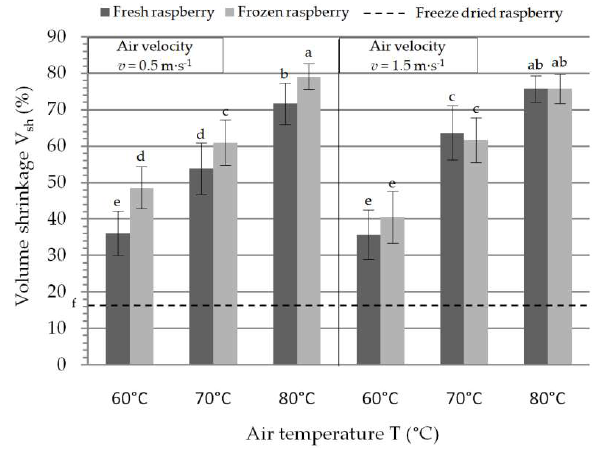
Figure 1. Volume shrinkage after convective drying of raspberry variety Polana. Di ff erent lowercase letters indicate significant differences ( p < 0.05).